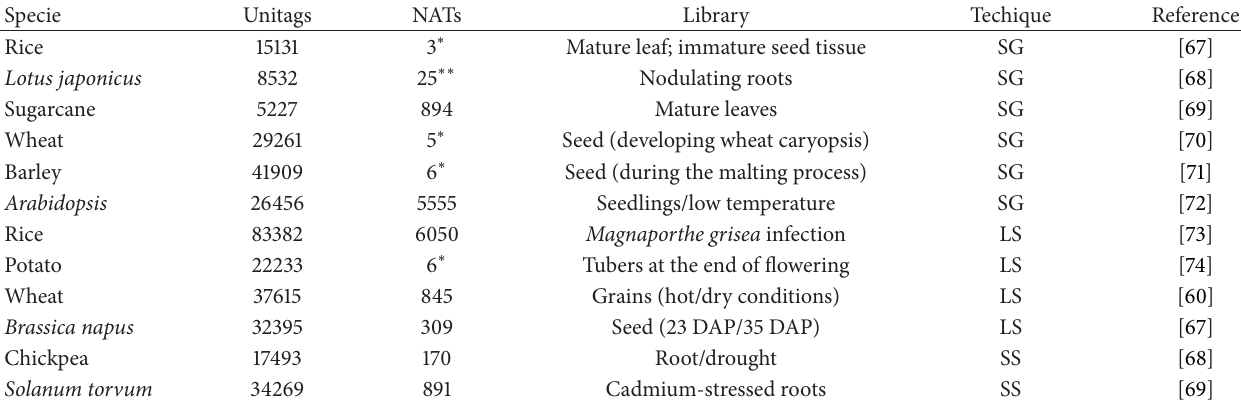
Table 1: NAT prospection in plant studies using SAGE or derivatives